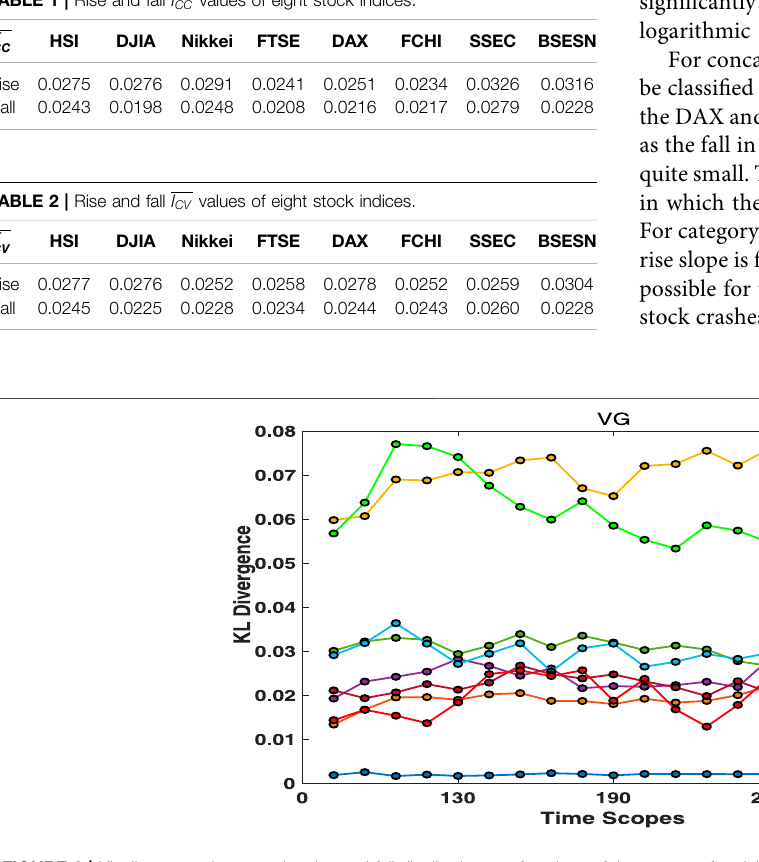
TABLE 1 | Rise and fall I CC values of eight stock indices.